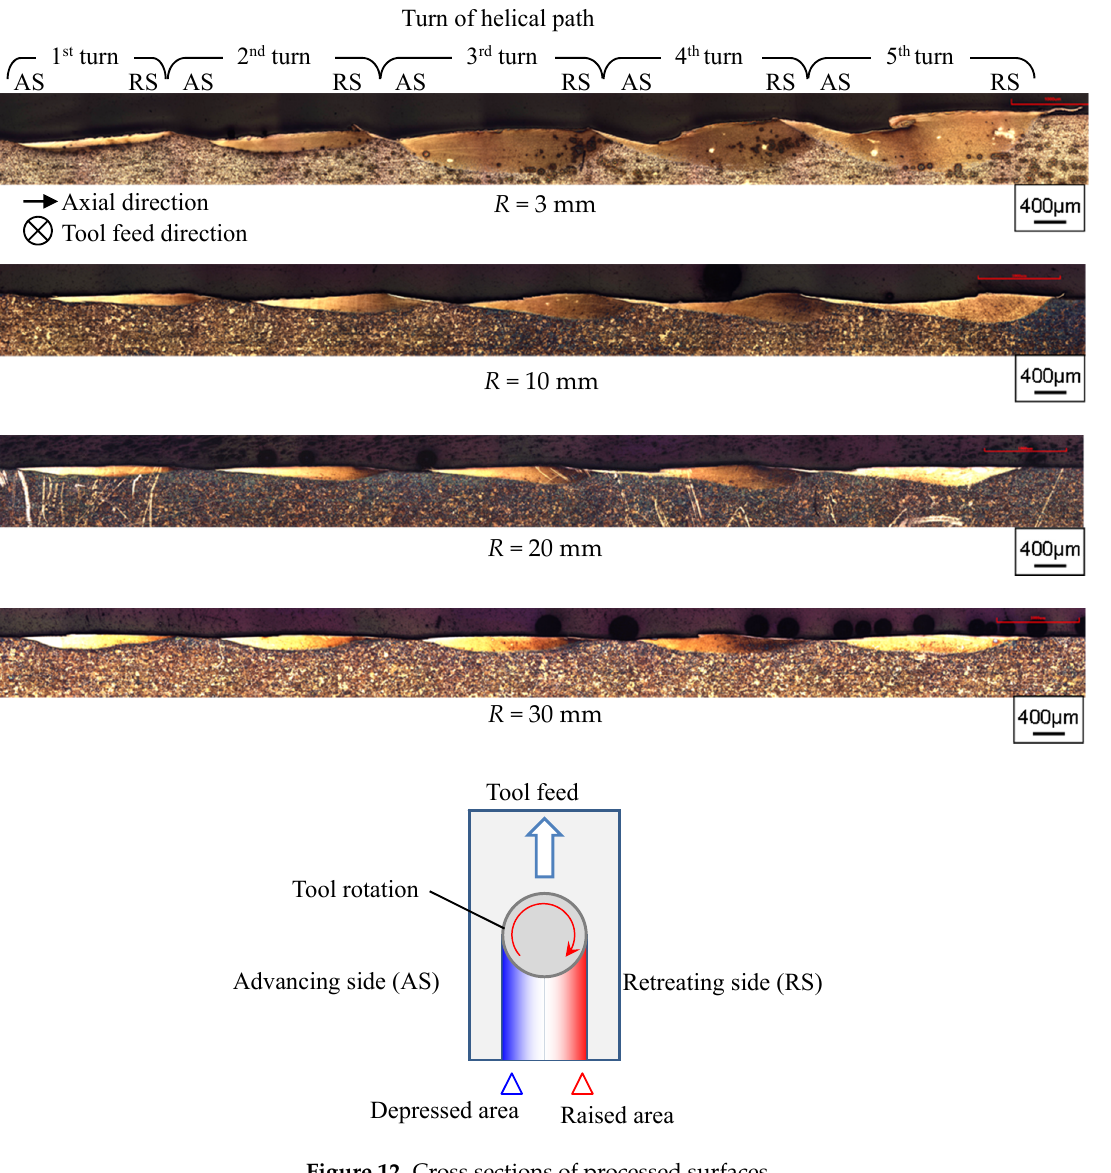
Figure 13. Hardness distributions on cross section of processed surfaces.